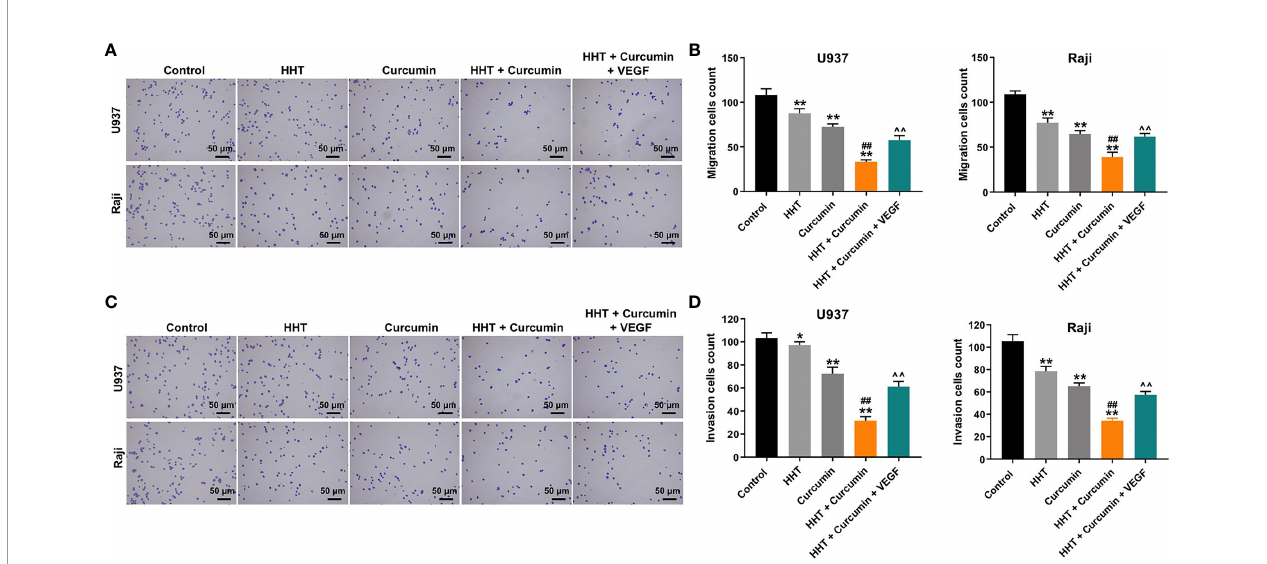
FIGURE 2 | Combination of curcumin with HHT suppressed the migration and invasion abilities of lymphoma cells. U937 and Raji cells were treated with 5 ng/mL HHT or/and 10 m M curcumin, or treated with HHT, curcumin and VEGF for 24 h. (A, B) Cell migration was detected by transwell migration assay. (C, D) Cell invasion was detected by transwell invasion assay. *P < 0.05, **P < 0.01 compared with control group; ## P < 0.01 compared with HHT group; ^^ P < 0.01 compared with HHT + curcumin